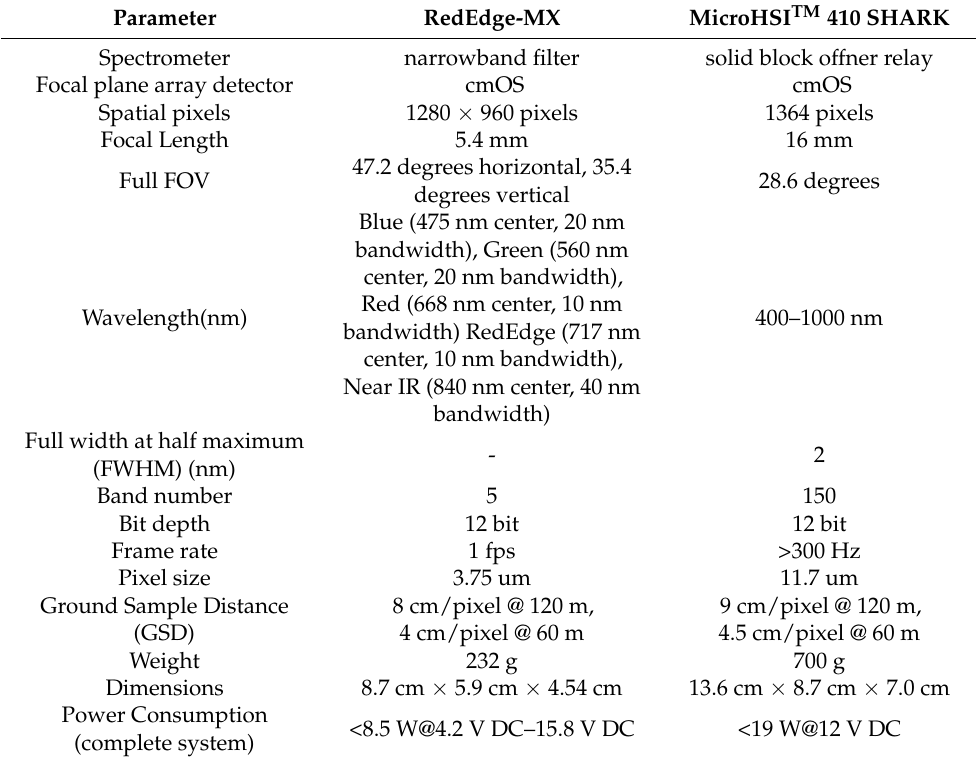
Table 1. Main specifications for some components of the hyperspectral UAV